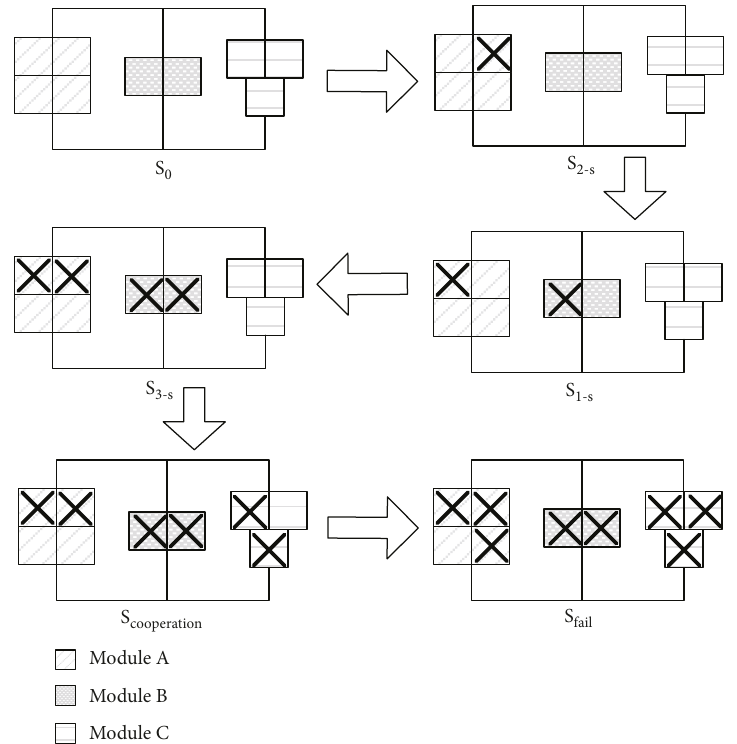
Figure 5: The change of the system state during a recon fi guration